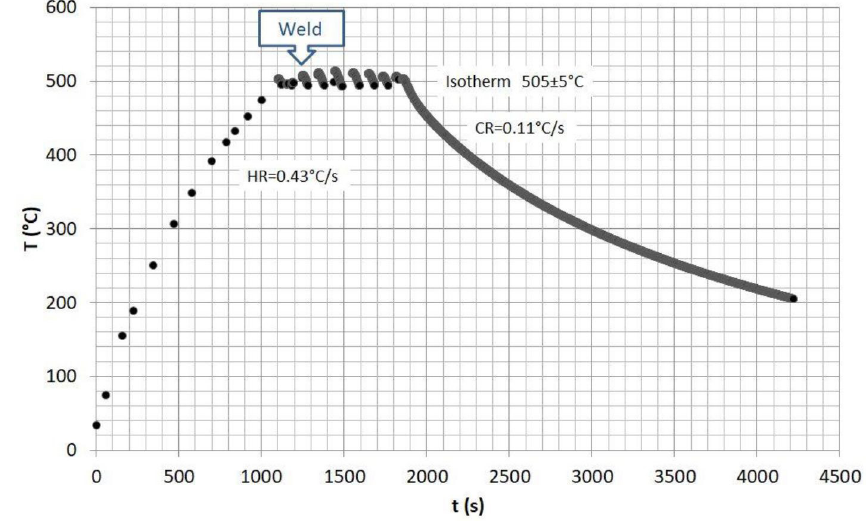
Figure 2. Temperature measurement of the thermocouple as a function of time. The laser weld start time is marked by an arrow. The isotherm temperature, heating rate (HR) and cooling rate (CR) are